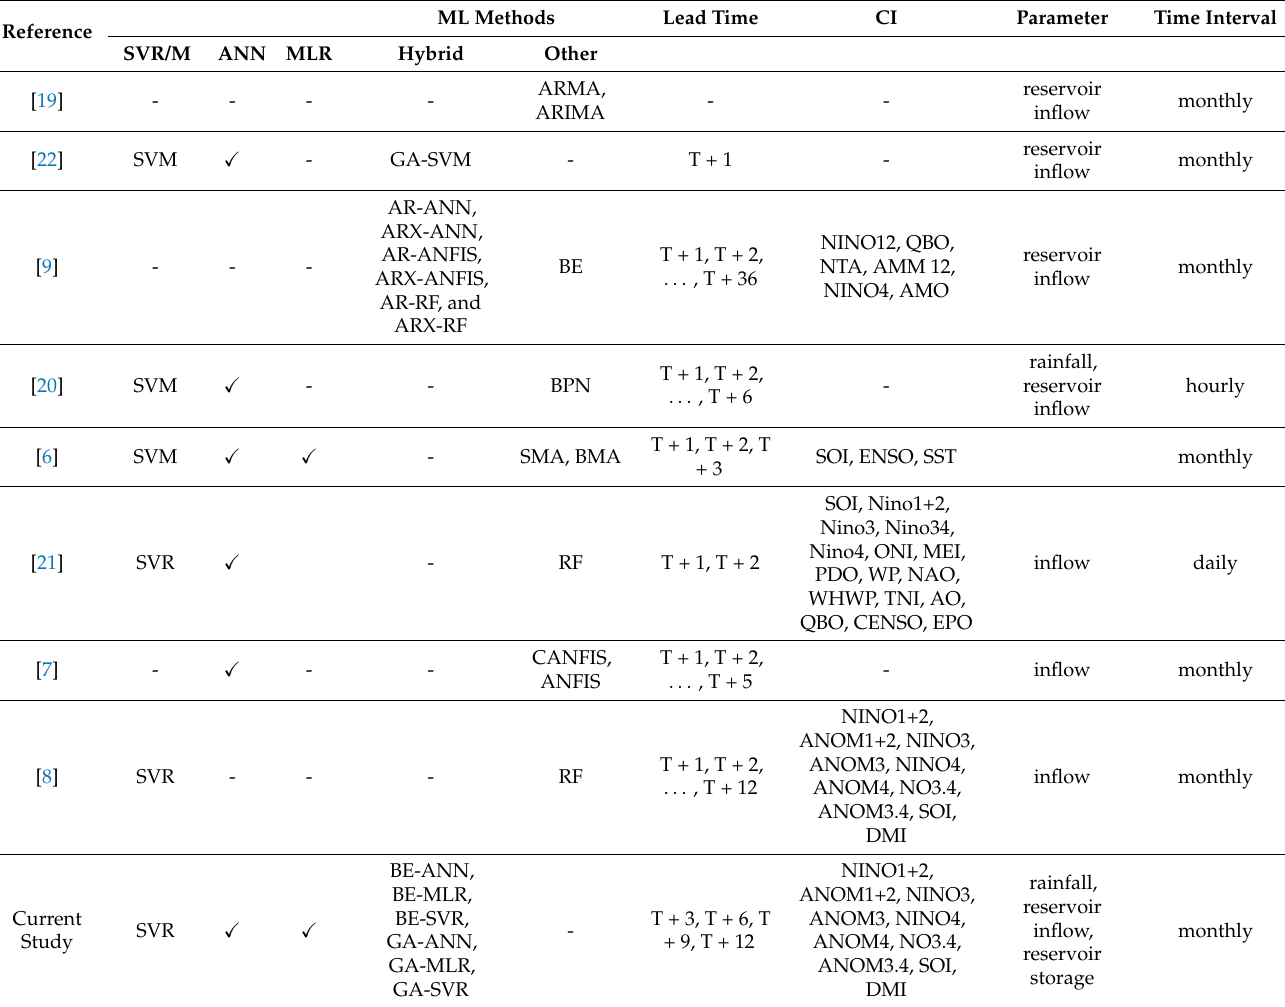
Table 1. Previous research on machine learning methods for reservoir inflow